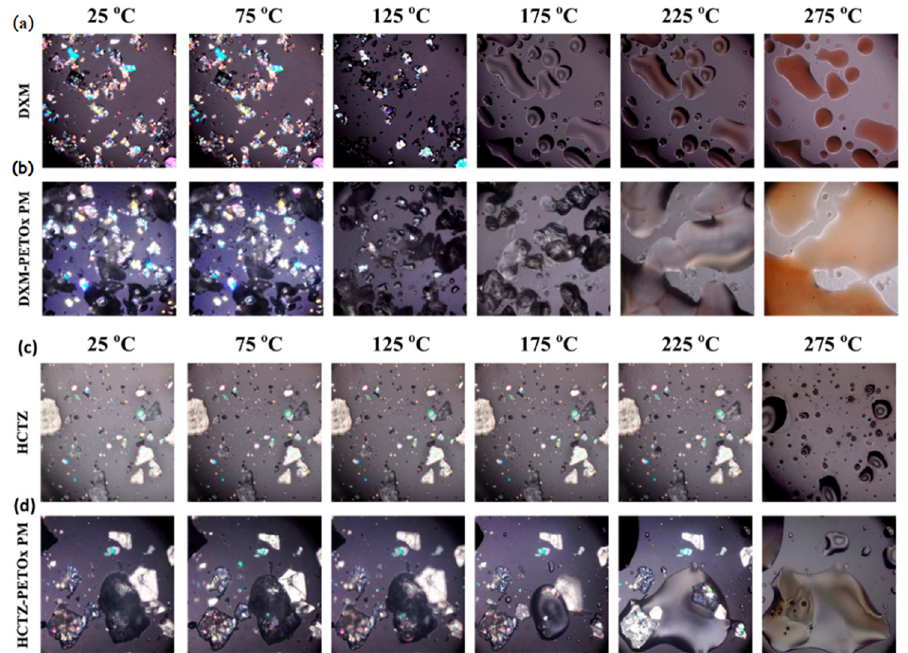
Figure 1. Hot-stage microscopy of powdered samples of ( a ) DXM, ( b ) DXM with PETOx, ( c ) HCTZ, ( d ) HCTZ with PETOx.